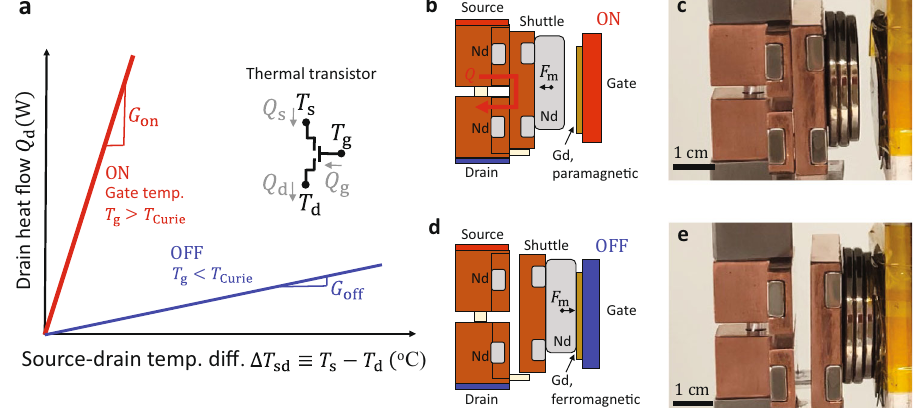
Fig. 1 | Thermal transistor conceptand implementation. a In our three-terminal thermal transistor,the drain heat fl ow Q d iscontrolled by the gate temperature T g at a fi xed source-drain temperature difference Δ T sd . The mechanism leverages T g -dependent magnetic forces between gadolinium (Gd) and neodymium (Nd) magnets to achieve source – drain thermal conductances G (cid:2) Q d = Δ T sd that are larger in the high- T g ON state ( G on ,red) than in the low- T g OFF state ( G off ,blue). b Schematicand c opticalimageofthetransistorinthehigh-